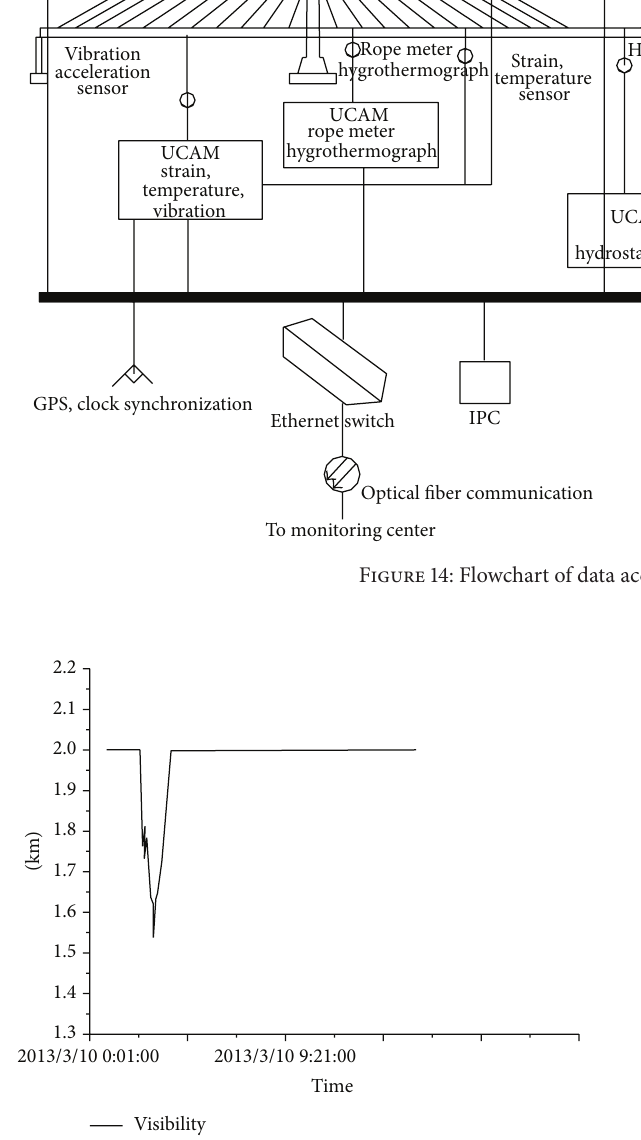
Figure 15: External environment of the bridge.